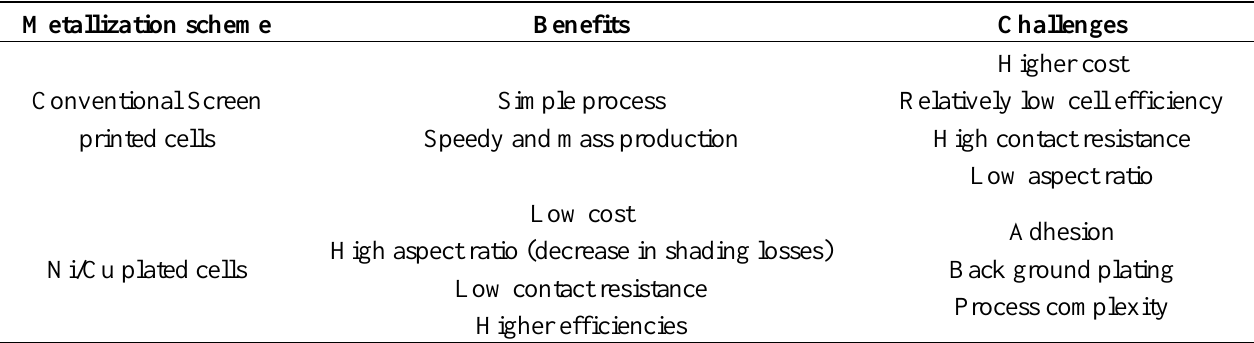
Table 2. Conventional Screen printed cells versus cells based on Ni/Cu plating